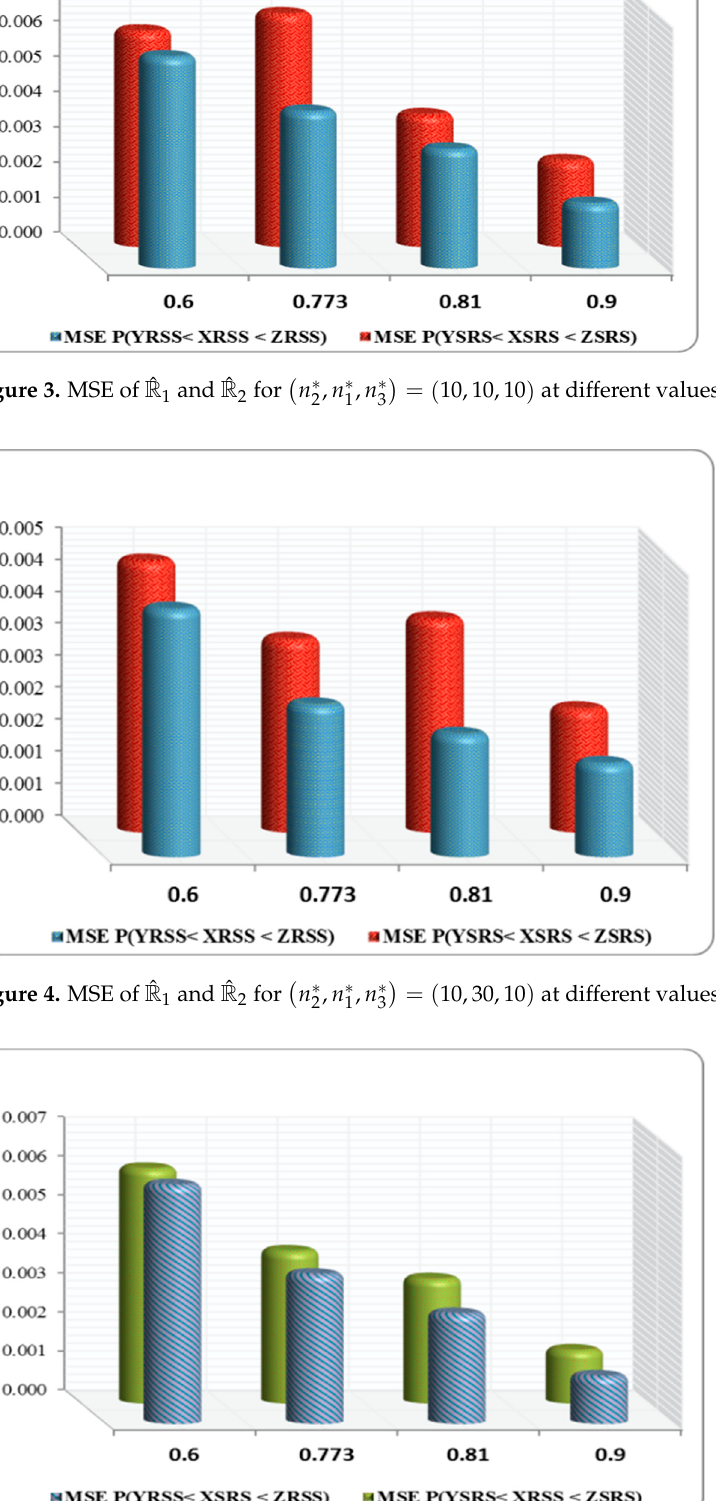
(cid:0) (cid:1) = ( ˆ R n 2 , n ∗ , n 3 2,20,2 ) at different values of R 3 and 4 for 1